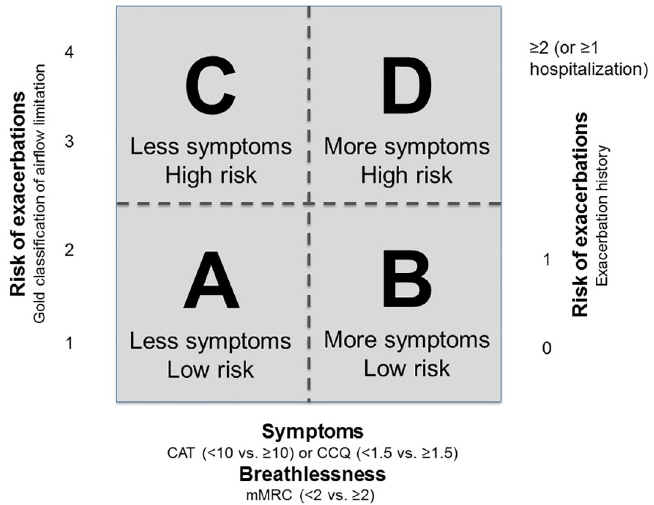
Fig 1. The new GOLD assessment. The classification combines the symptomatic assessment with the patients ’ spirometric classification and/or risk of exacerbations, resulting in 4 quadrants. To classify patients first symptoms should be assessed with the mMRC, CAT or CCQ scale and investigator should determine if the patient belongs to the left (less symptoms) or right (more symptoms) side of the box. Next the risk of exacerbations should be assessed to determine if the patient belongs to the lower part of the box (low risk) or the upper part of the box (higher risk). When assessing symptoms the mMRC, CAT or the CCQ scale can be used; when assessing risk the highest risk according to GOLD grade or exacerbation history should be